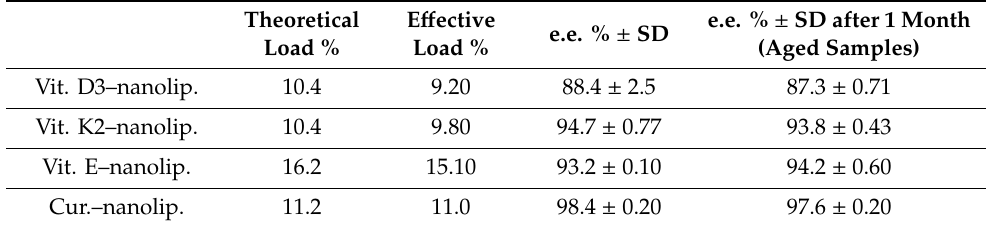
Table 2. Vitamin D3-, vitamin K2-, vitamin E-, and curcumin-loaded nanoliposome characterization in terms of theoretical load, e ff ective load, and encapsulation e ffi ciency (e.e.) at time zero and after 1 month storage (aged samples) at 4 ◦ C. Measured data are expressed as average of three determinations and reported along with the standard deviation